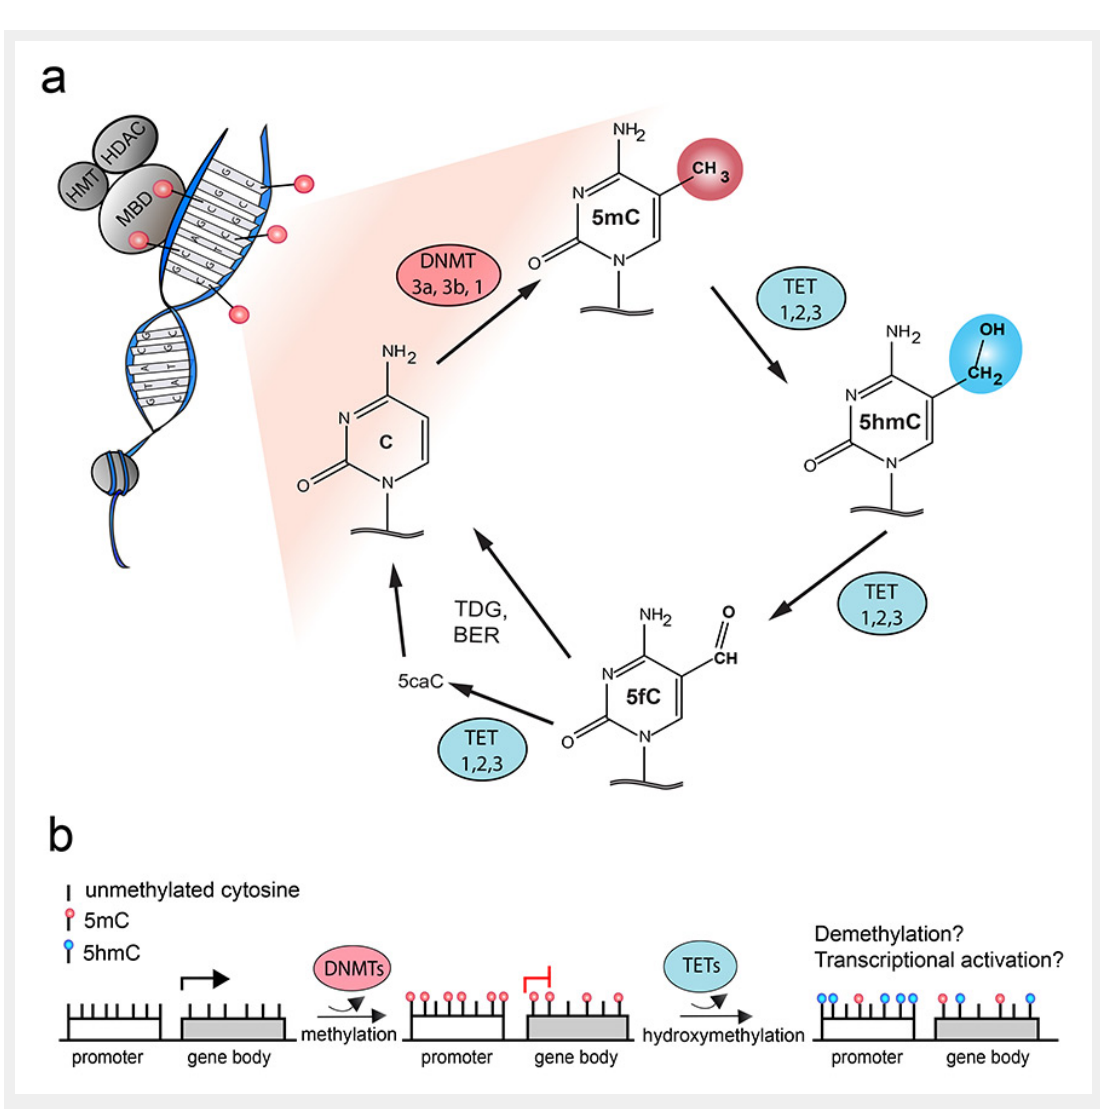
DNA methylation and hydroxymethylation. Cytosine modifications in DNA have functional consequences on gene expression. (a) Cytosine can be methylated by DNMT enzymes to give rise to 5mC, which can be oxidised by TET enzymes to 5hmC and further products (5fC and 5caC). In an active demethylation pathway, these products of TET enzymatic activity are likely to be excised and repaired by the thymine-DNA glycosylase enzyme and base excision repair mechanisms to regenerate the unmodified cytosine. Methylated DNA can be recognised by MBD proteins that can recruit histone modifying complexes (HMTs and HDACs). (b) DNA methylation occurs at regulatory regions (such as promoters), but also in gene bodies. DNMT enzymes are responsible for 5mC deposition, often resulting in the transcriptional repression of the methylated promoter. TET proteins activity can lead to demethylation with a potential for transcriptional activation. 5caC = 5-carboxylcytosine; 5fC = 5-formylcytosine; 5hmC = 5-hydroxymethylcytosine; 5mC = 5-methylcytosine; BER = base excision repair; DNMT = DNA methyltransferase; HDAC = histone deacetylase; HMT = histone methyltransferase; MBD = methyl-CpG-binding domain protein; TDG = thymine-DNA glycosylase; TET = ten-eleven